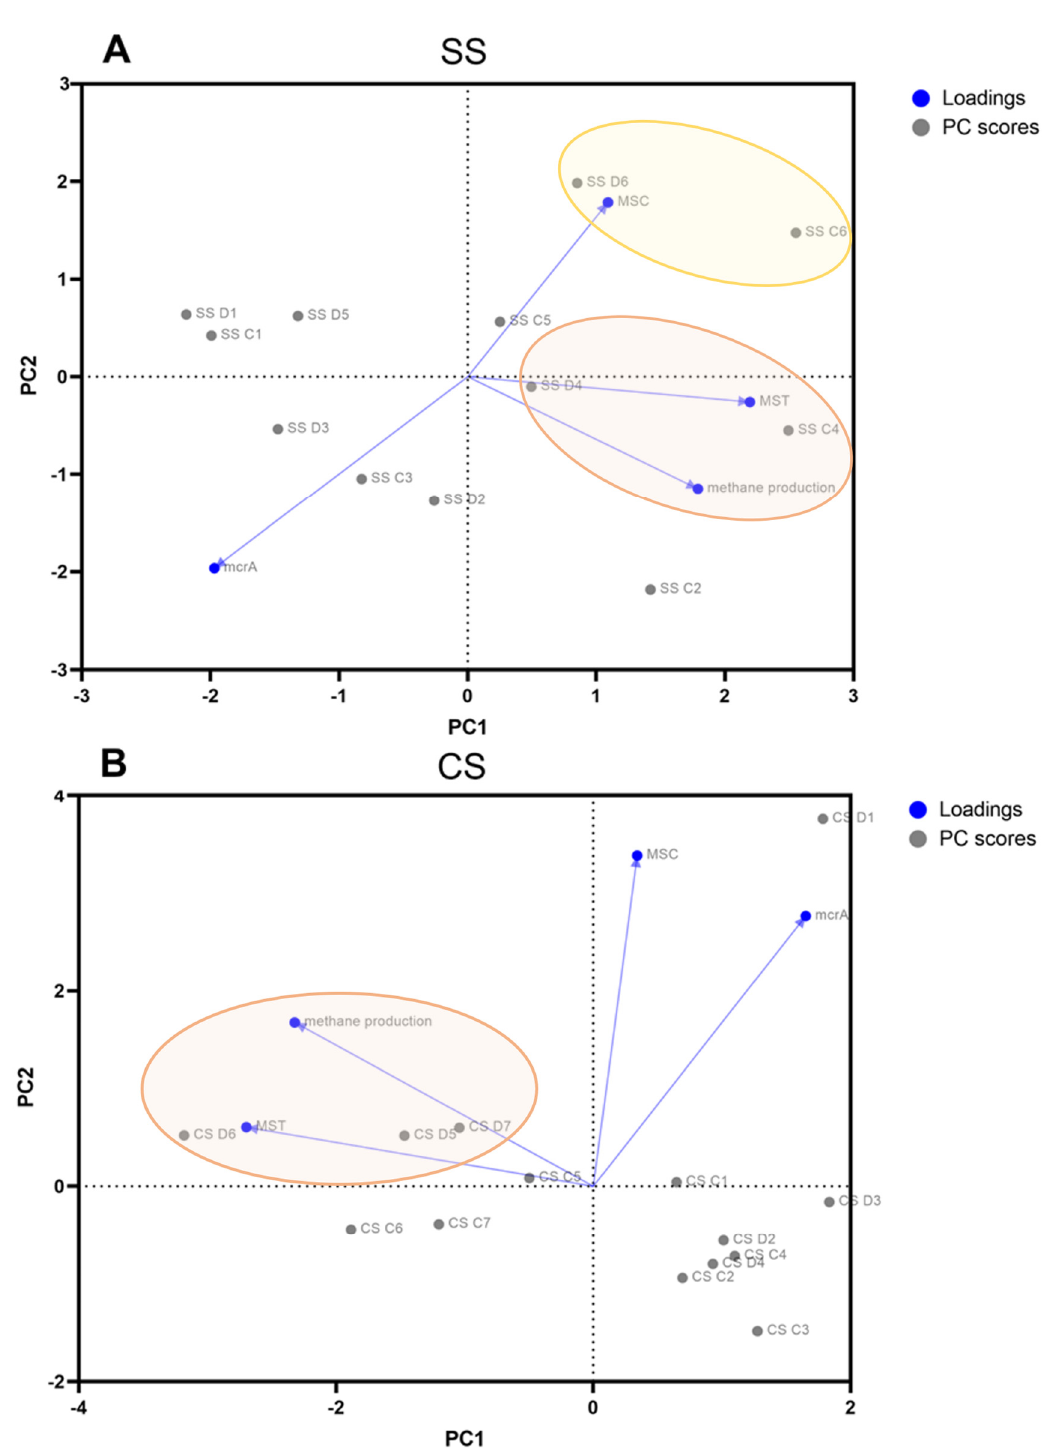
Figure 3. Ordination analysis of sewage sludge (( A ) SS) and cattle slurry (( B ) CS) samples from process and control bioreactors. Principal component analysis (PCA) of the abundance of mcr A gene, genes characteristics for Methanosarcinaceae (MSC), Methanosaetaceae (MST), and methane production. D—dose ID, C—control.